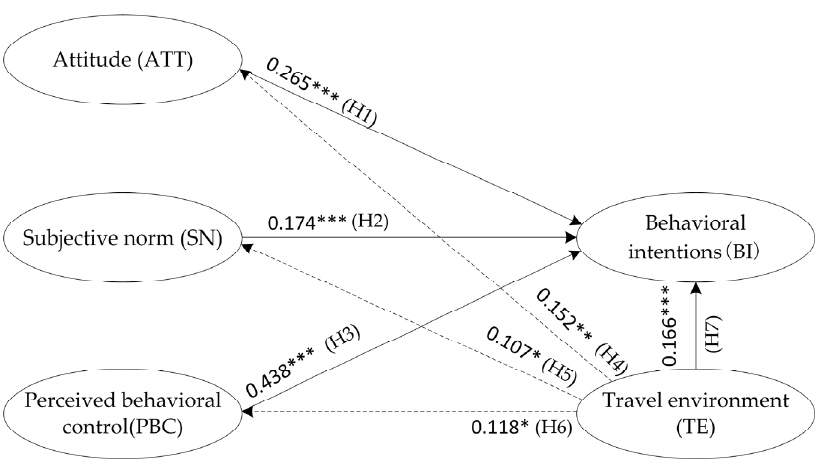
Figure 4. Result of structural equation model. Note: *** p < 0.01, ** p < 0.05, * p < 0.1.